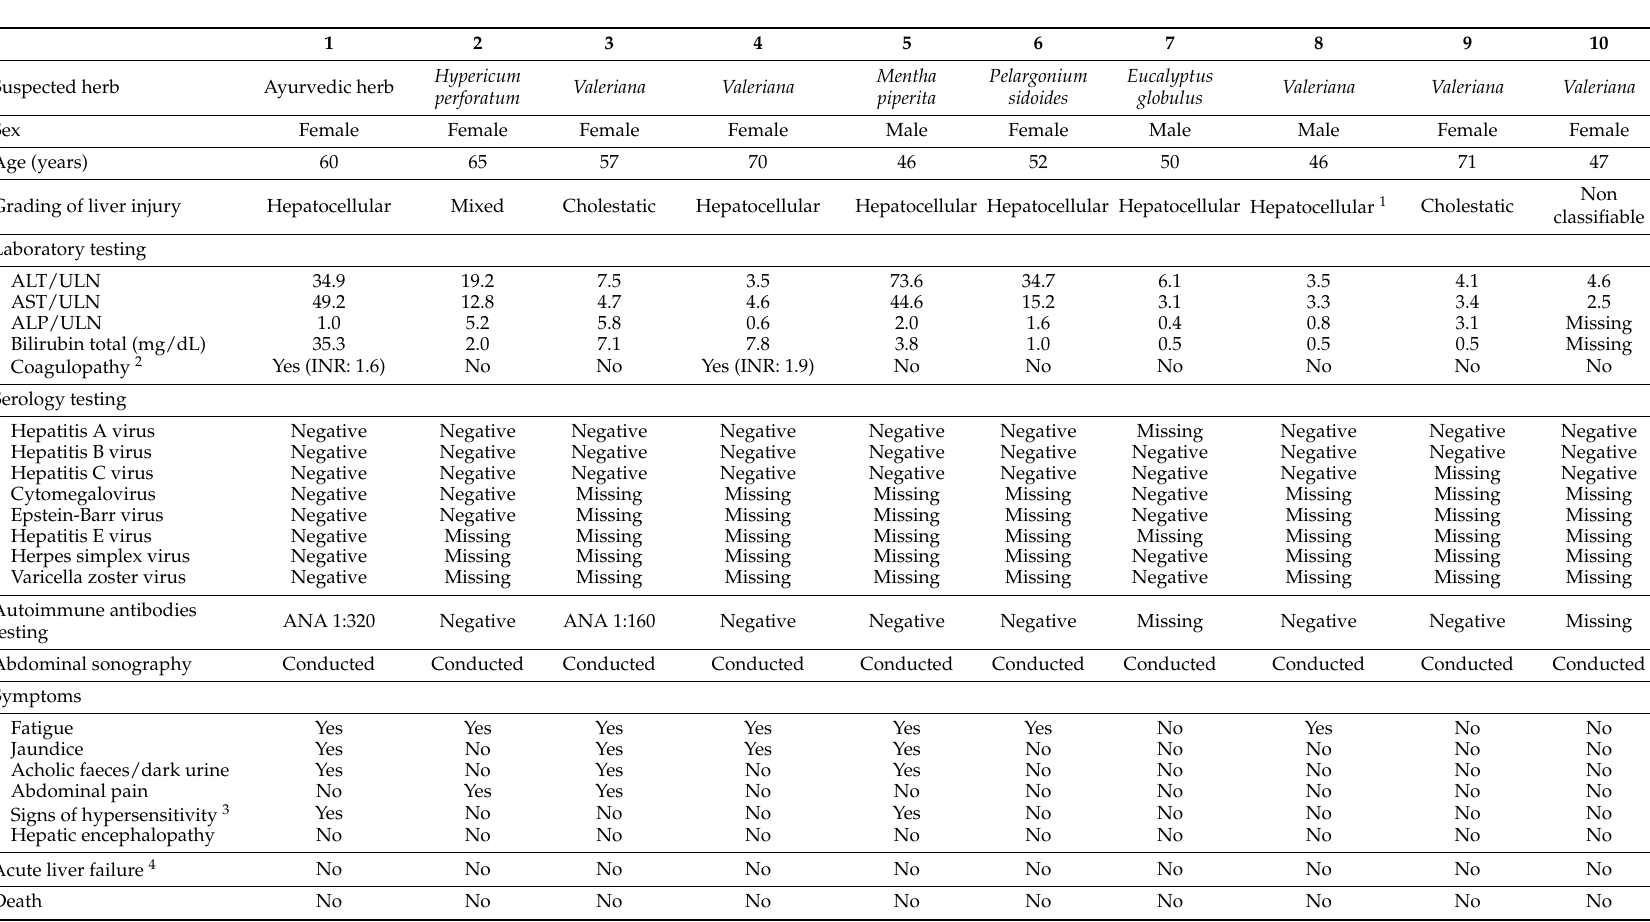
Table 1. Selected demographic, clinical, and laboratory data of the patients with herb-induced liver